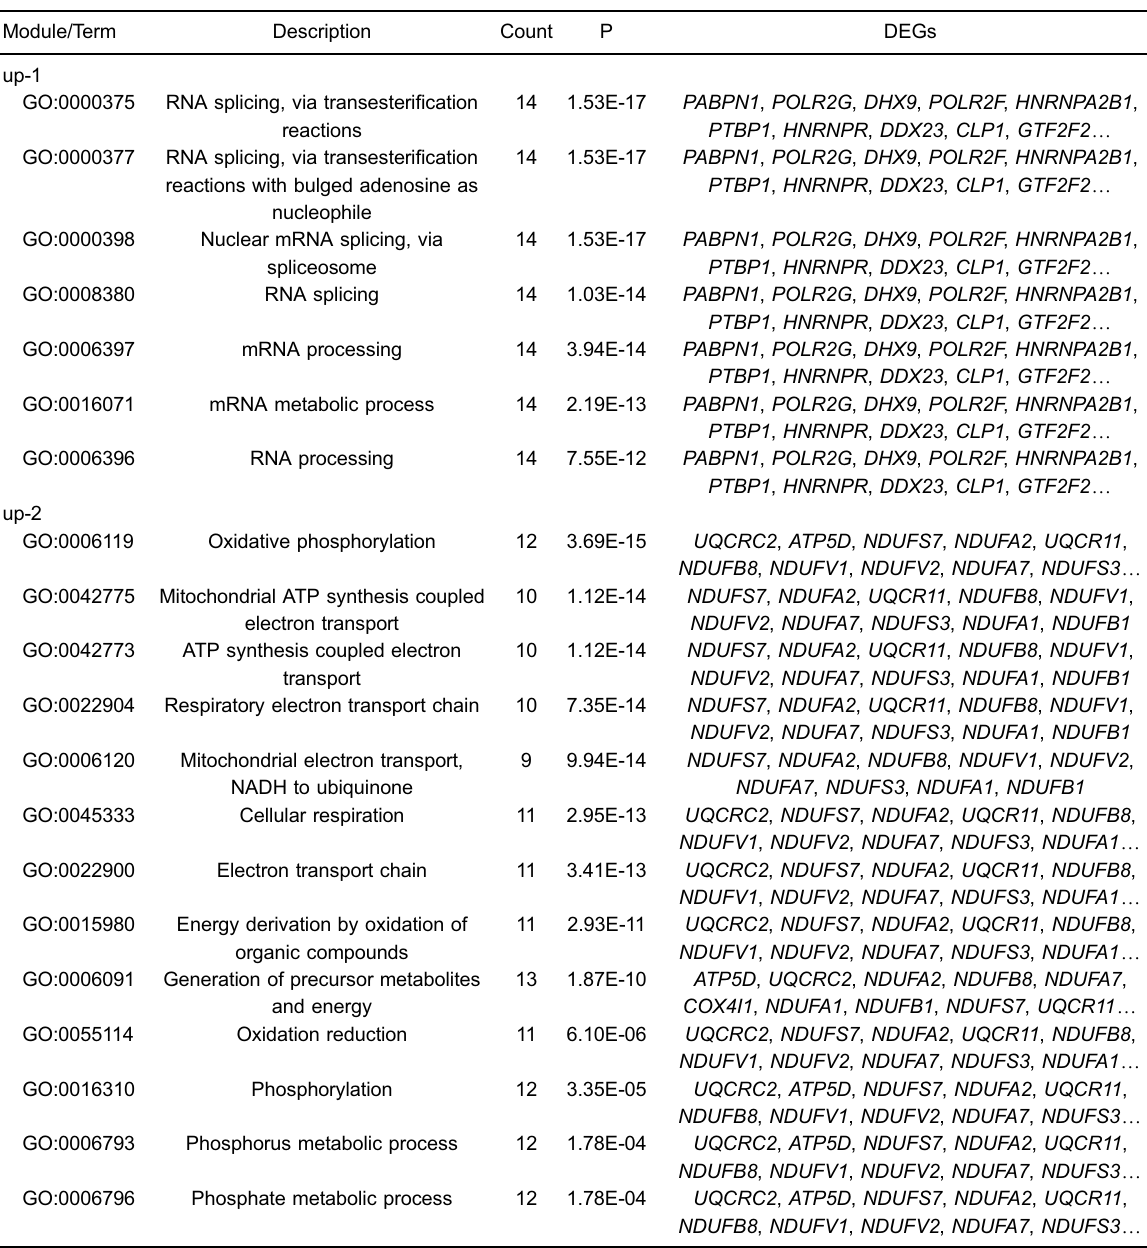
Table 2. Enriched functions for genes in upregulated modules with a higher enrichment